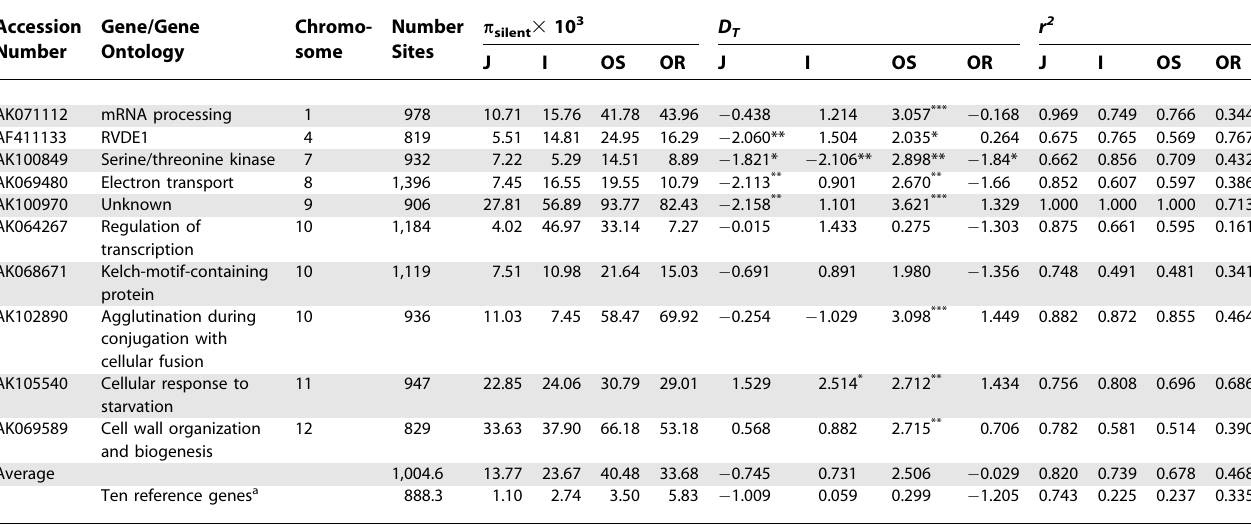
Table 1. Statistics for High Polymorphism and Reference Genes in Rice Cultivars and O. rufipogon Accession Gene/Gene Chromo- Number Ontology